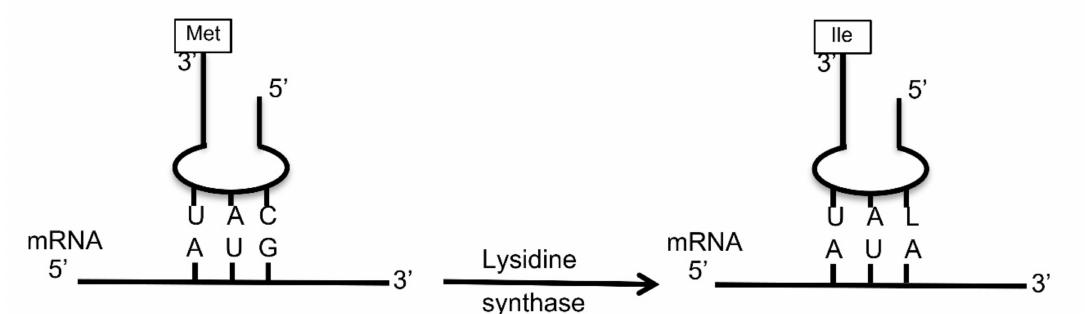
Figure 1. Simplified diagram of tRNA anticodon base pairing with the mRNA codon. The tRNA Met anticodon 3 (cid:48) UAC 5 (cid:48) recognizes the codon 5 (cid:48) AUG 3 (cid:48) (left figure). The enzyme tRNA isoleucine lysidine synthase (TilS) attaches lysine to the 5 (cid:48) cytosine of the tRNA, which becomes lysidine. Lysidine base pairs with adenine. As such, the modified tRNA now recognizes the isoleucine codon